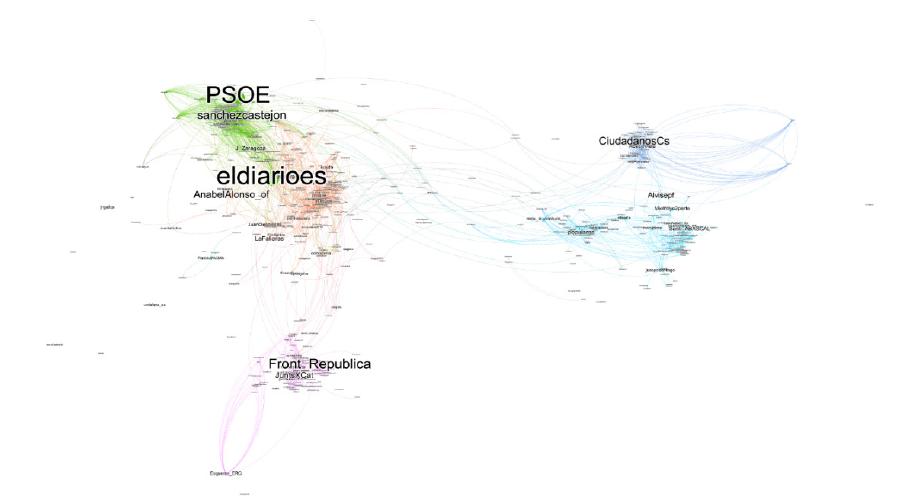
Figure 2. Influencers in the retweet